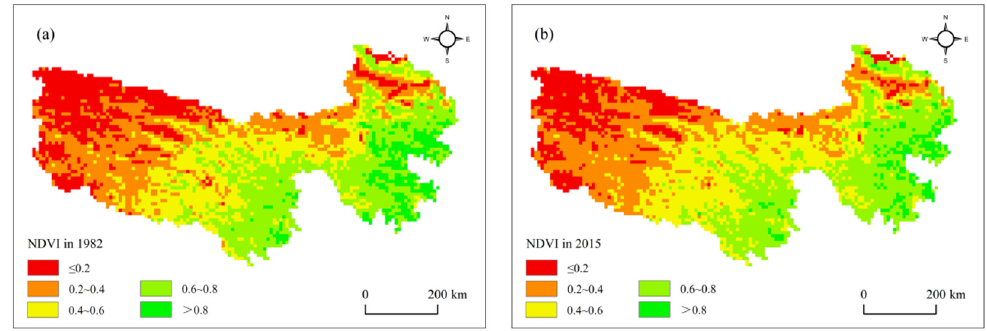
Figure 3. Spatial distributions of the NDVI ： (a) NDVI in 1982; (b) NDVI in 2015.